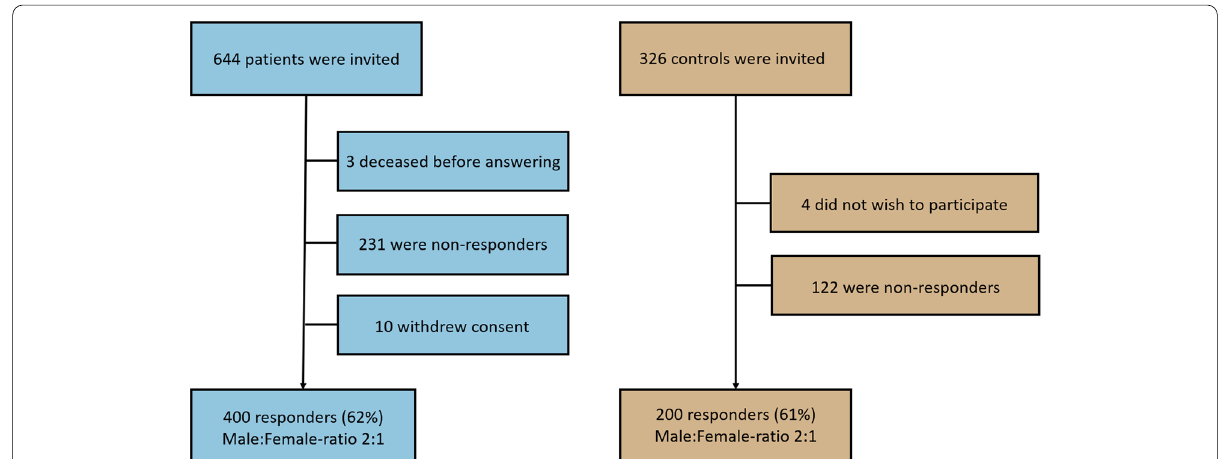
Fig. 1 Flowchart of inclusion. Data presented for 400 patients with cluster headache. Means (SD) are based on the entire population, not only the patients receiving the specific healthcare service or social benefit. Underneath the cost the patients who received the service or benefit within the last year are indicated. The costs were not normally distributed, and we therefore applied the non-parametric Wilcoxon test. Some total costs do not total the sum of the means due to